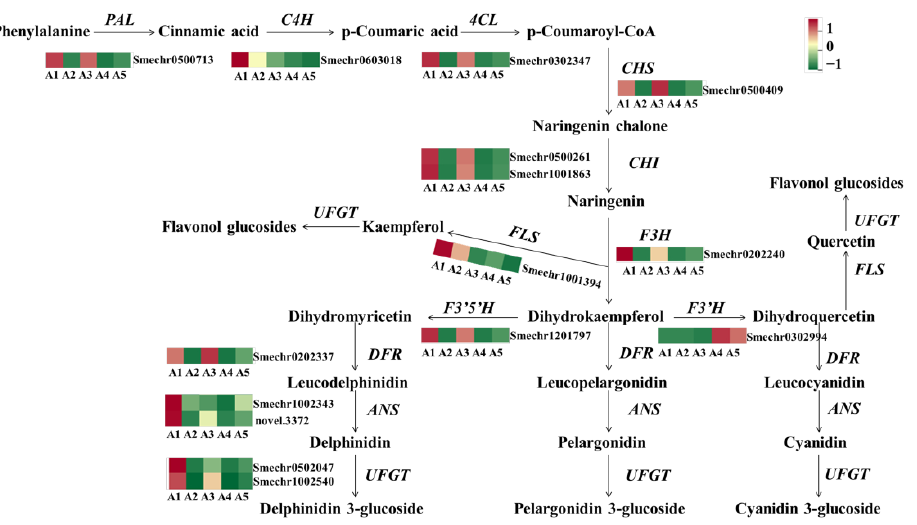
Figure 6. The expression profiles of genes involved in the anthocyanin/flavonoid pathway. PAL, phenylalanine ammonia lyase; C4H, cinnamate 4-hydroxylase; 4CL, 4-coumarate-CoA ligase; CHS, chalcone synthase; CHI, chalcone isomerase; F3H, flavanone 3-hydroxyl enzyme; FLS, flavonol synthase; DFR, dihydroflavonol reductase; ANS, anthocyanin synthase; UFGT, flavonoid 3-O-glucosyltransferase.